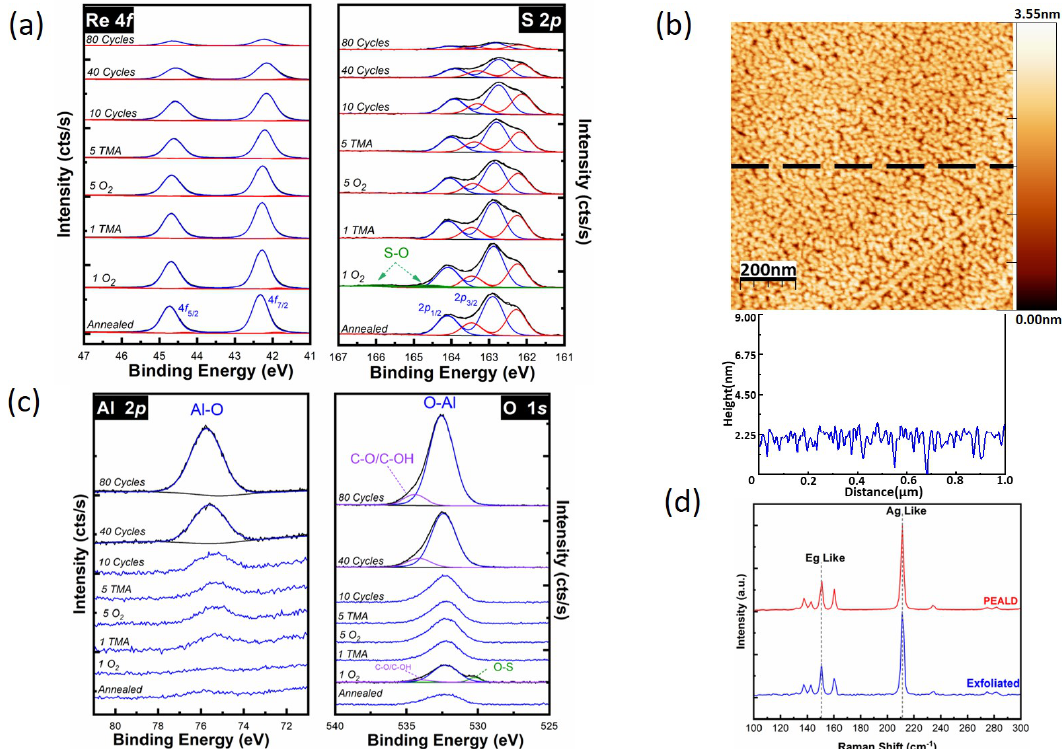
Figure 3. Plasma-enhanced atomic layer deposition (PEALD) of Al 2 O 3 on ReS 2 . ( a ) The evolution of ( a ) Re 4 f and S 2 p core level spectra, ( b ) Ex-situ AFM image and line profile recorded following 80 cycles PEALD of Al 2 O 3 , ( c ) Al 2 p and O 1 s core level spectra up to 80 cycles of Al 2 O 3 , and ( d ) Raman spectra recorded on exfoliated ReS 2 and after 80 cycles of PEALD of Al 2 O 3